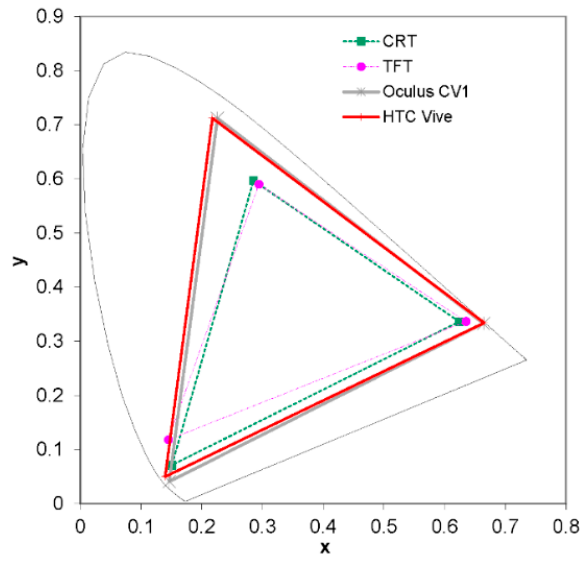
Figure 4. Color gamut of HTC Vive displays compared to the color gamut of different types of displays.